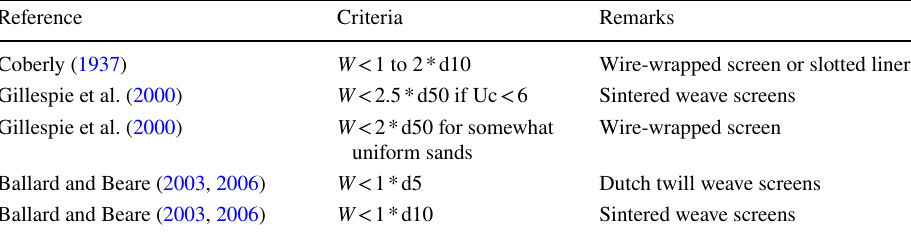
selection criterion for sand control aperture (Wu et al.